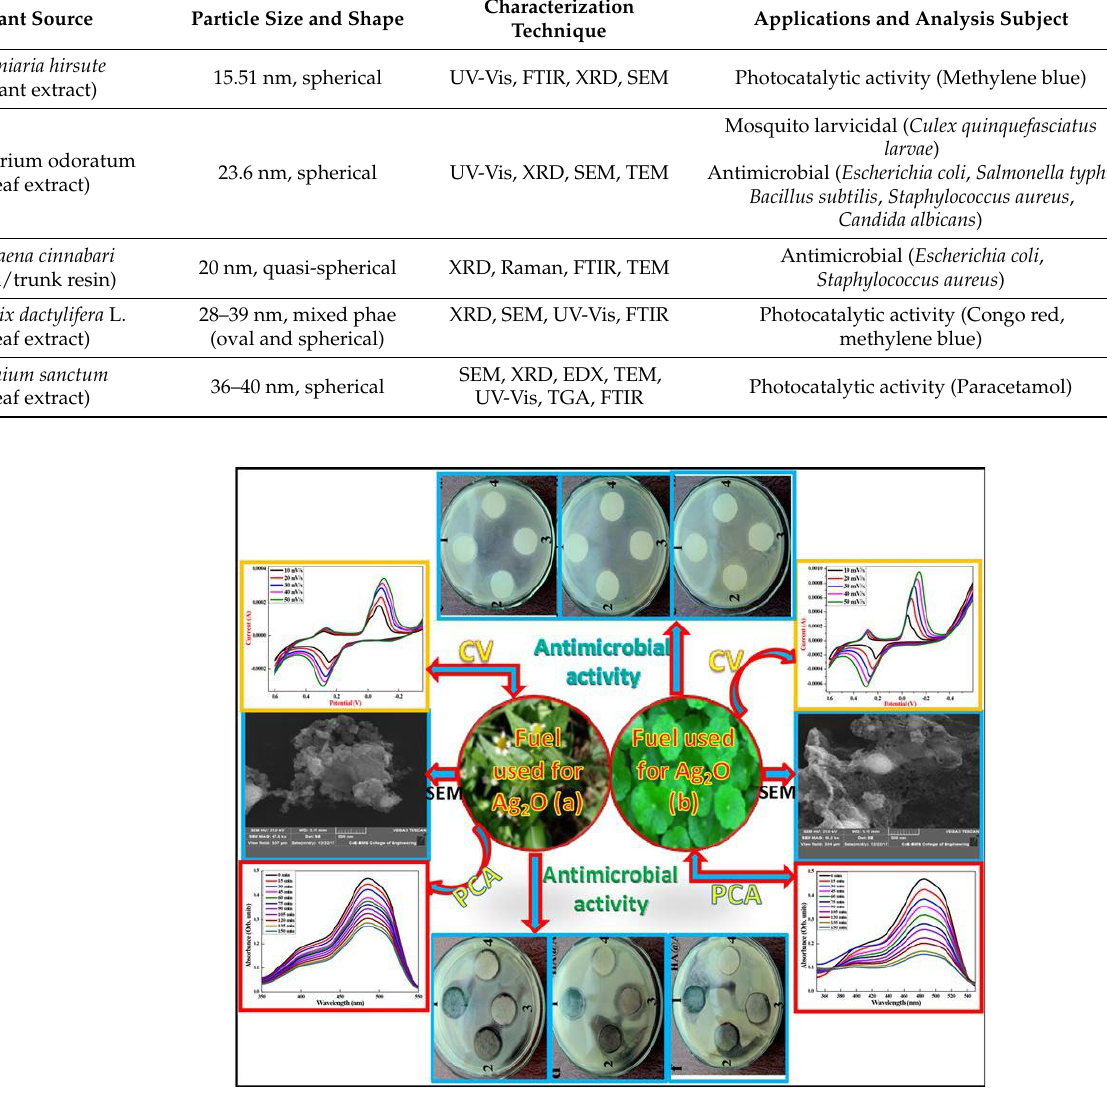
Figure 3. Top: Cyclic Voltammogram and SEM micrographs and of Ag 2 O nanoparticles prepared using ( left ) Centella asiatica ( right ) Tridax . Bottom: Absorbance of Ag 2 O NPs: ( left ) Centella asiatica and ( right ) Tridax plant extract using AO-8 dye photocatalyst under UV light irradiation. Reprinted with permission from Ref. [31] Copyright 2020 Elsevier.